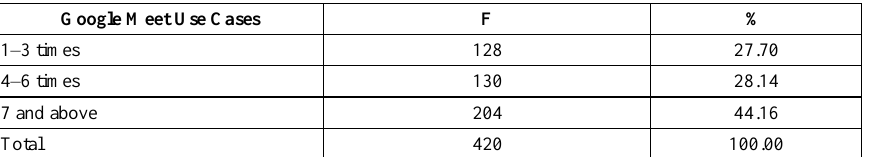
Table 4. Google Meet (asynchronous videos) usage cases of university students